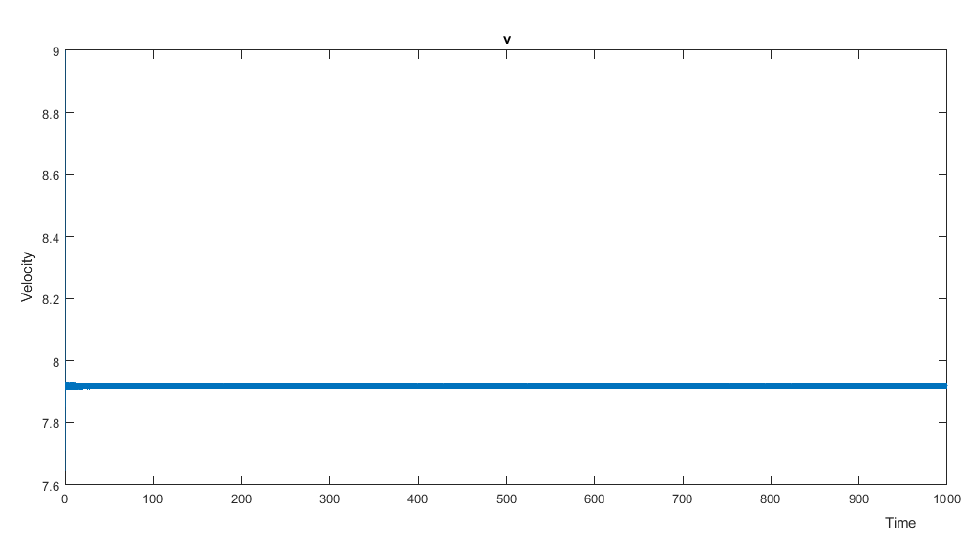
Figure 4. Velocity evolution for a Reynold’s number of 10.